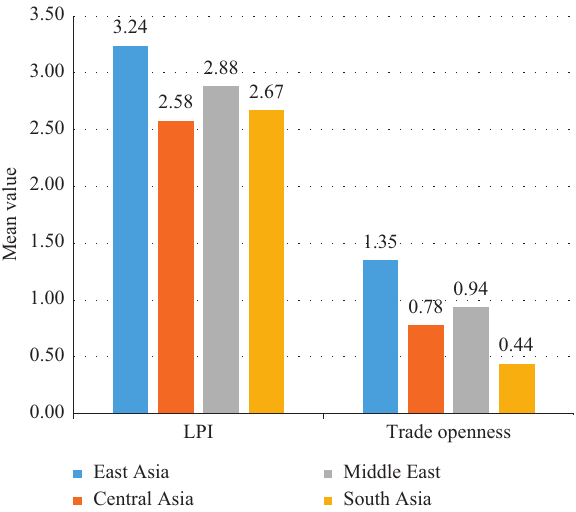
Figure 2: LPI and trade values in the subregions of Asia